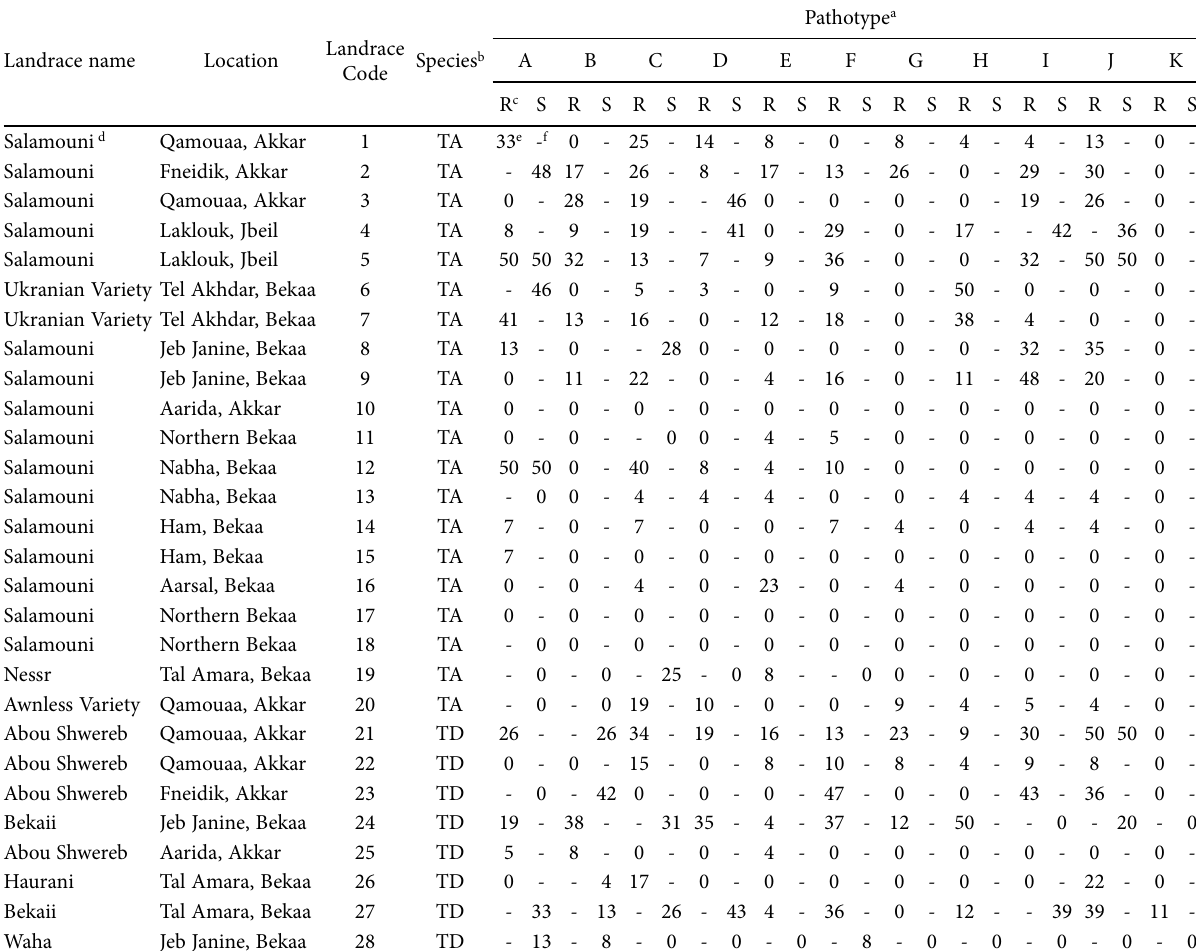
Table 6. Assessment of resistance heterogeneity in the wheat landraces, expressed as the percentage of resistant plants (R) among the sus- ceptible landraces, and the percentage of susceptible plants (S) among the resistant landraces, for each of the 11 Puccinia striiformis f. sp. tritici